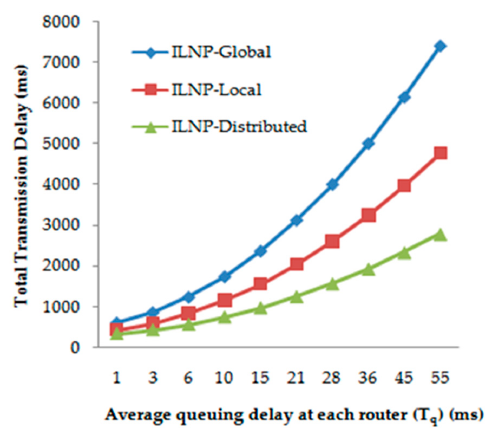
Figure 14. Impact of T q on TTD.